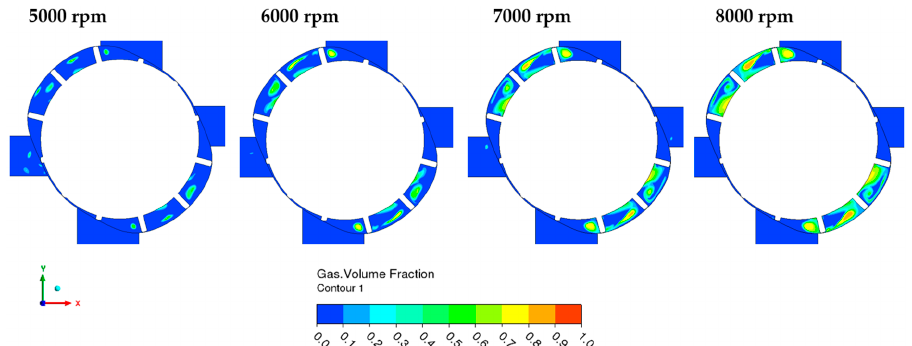
Figure 18. Development of the vapor gas volume fraction distribution at 5-bar delivery pressure for different rotational speeds.